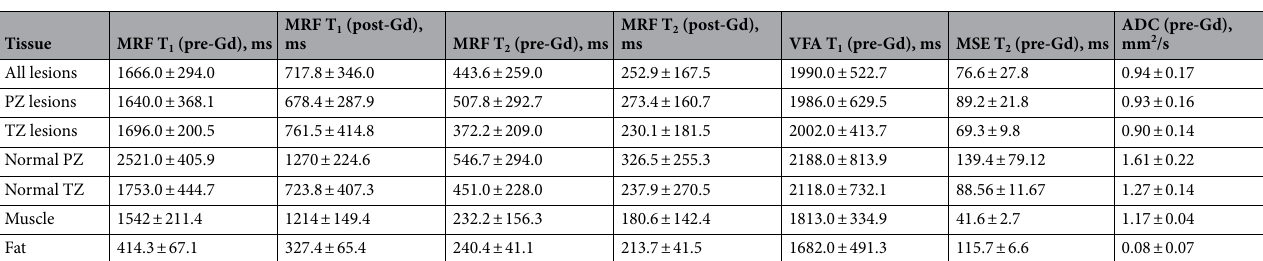
Table 1. Summary values derived from different tissue types from MRF T 1 and T 2 maps obtained both before and after gadolinium-based contrast agent administration as well as those derived from pre-contrast VFA T 1